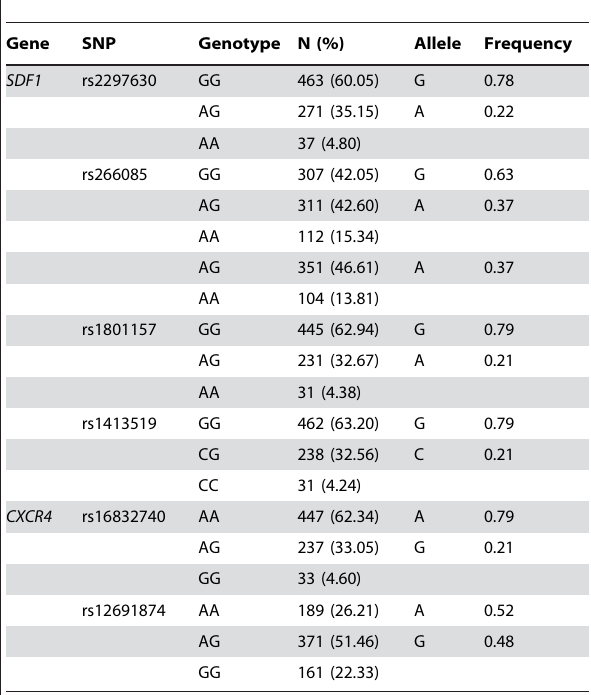
Table 2. Genotype and allele frequencies of SDF1 and